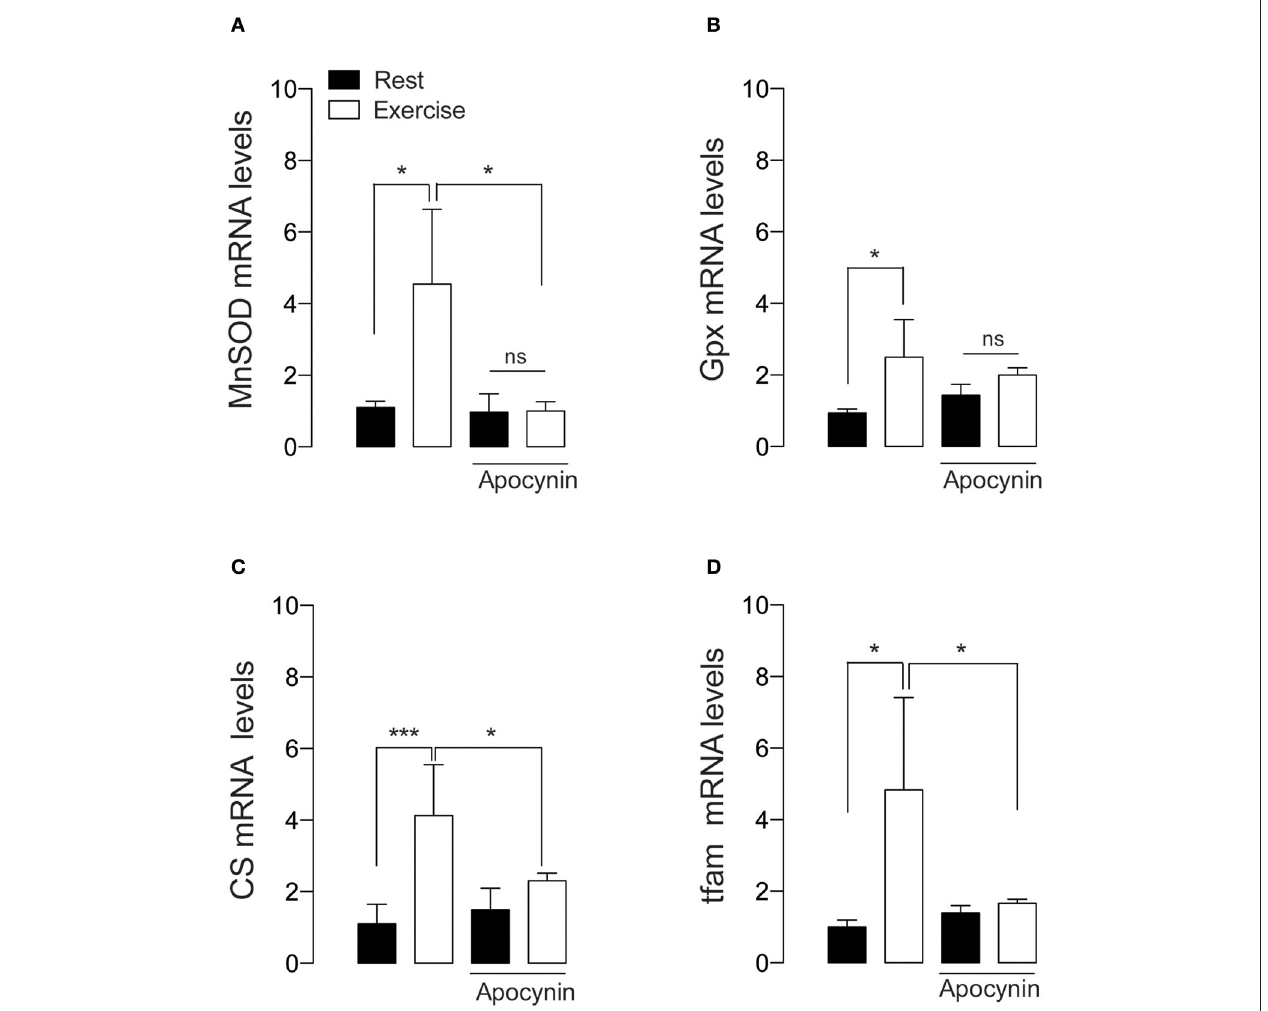
FIGURE 4 | NOX2 activation is necessary for exercise-induced antioxidant and mitochondrial gene expression. (A) Levels of mRNA for manganese superoxide dismutase (MnSOD), (B) Glutathione peroxidase (Gpx), (C) Citrate synthase (CS), and (D) mitochondrial transcription factor A (tfam) mRNAs were assessed by real time PCR in FDB muscle after swimming exercise. Data are expressed as mean ± SD from five different determinations. * p < 0.05 , *** p < 0.001 ; ns, no significant difference, one-way ANOVA-